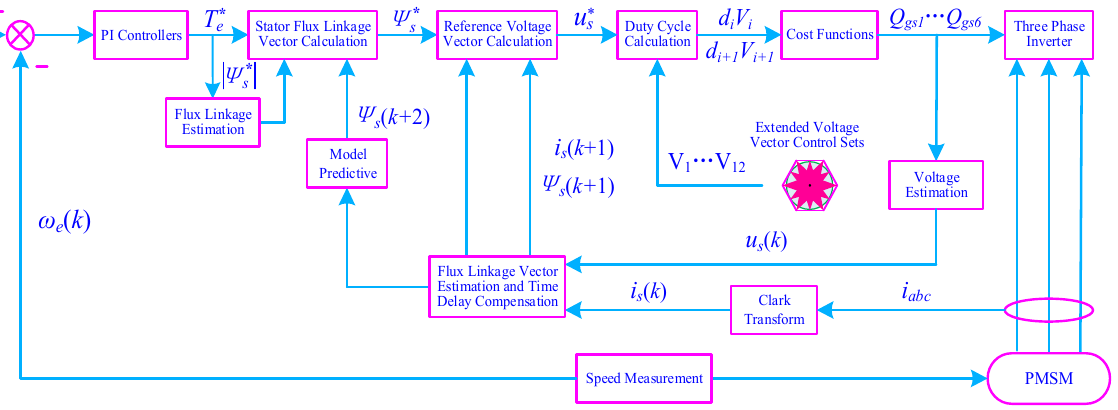
Figure 10. Block diagram of the optimization strategy for FCS-MPTC.